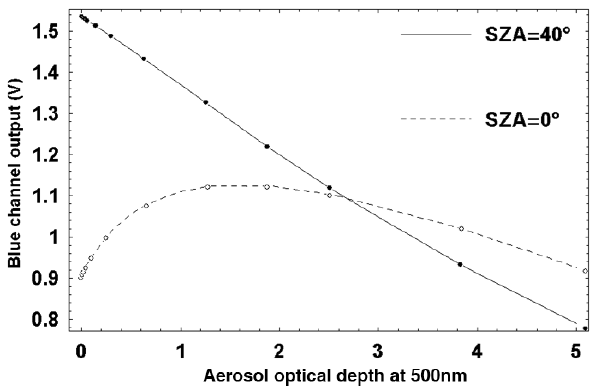
Figure 1. Solar flux received by ODS in the blue wavelength range as a function of the aerosol optical depth (AOD), at 40 ◦ SZA (solid line with black circles) for total direct and scattered sunlight and at 0 ◦ SZA (dashed line with white circles) for scattered sunlight only. The ratio between the two fluxes varies monotonously, with AOD providing a direct AOD measurement independent of sensor